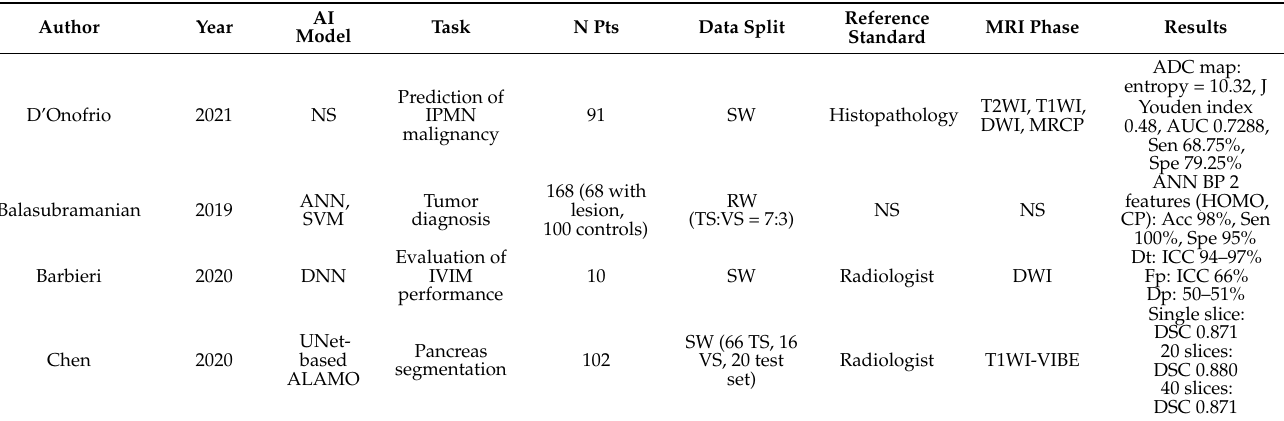
Table 8. Applications of CAD in pancreatic MRI